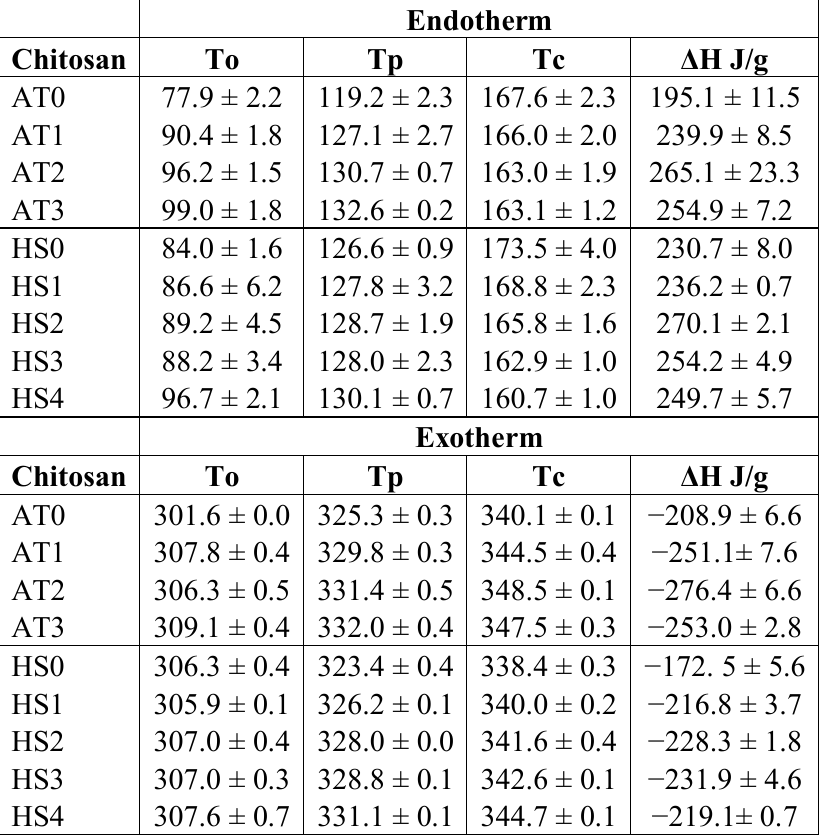
: completion temperature; ΔH: c